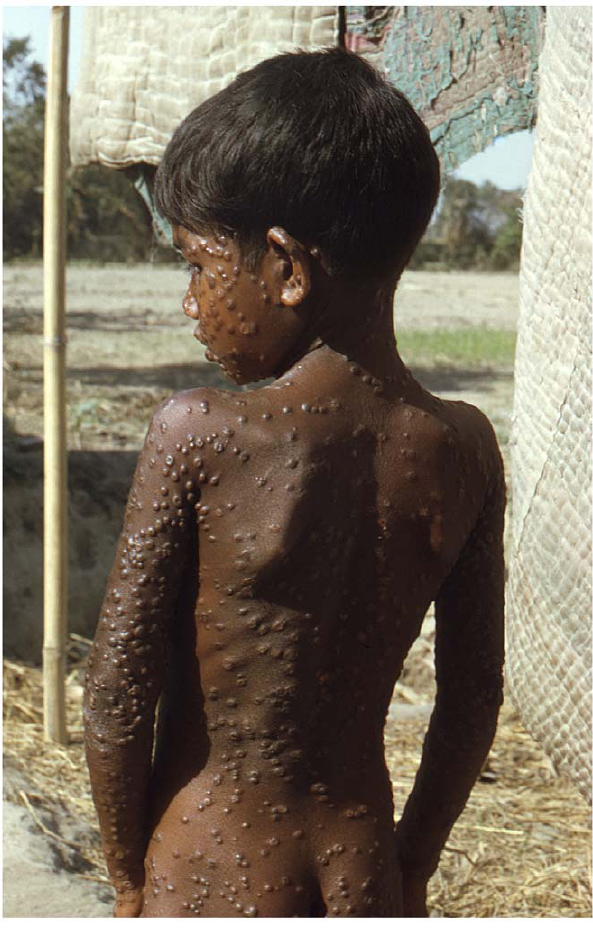
Figure 1. Smallpox is a uniquely human disease. This 1974 photo of a young villager in the Rangpur district of northeastern Bangladesh depicts one of the last known infections of a human with variola major virus. (Source: Jean Roy, Emory Global Health Institute, from the CDC Public Health Image Library at